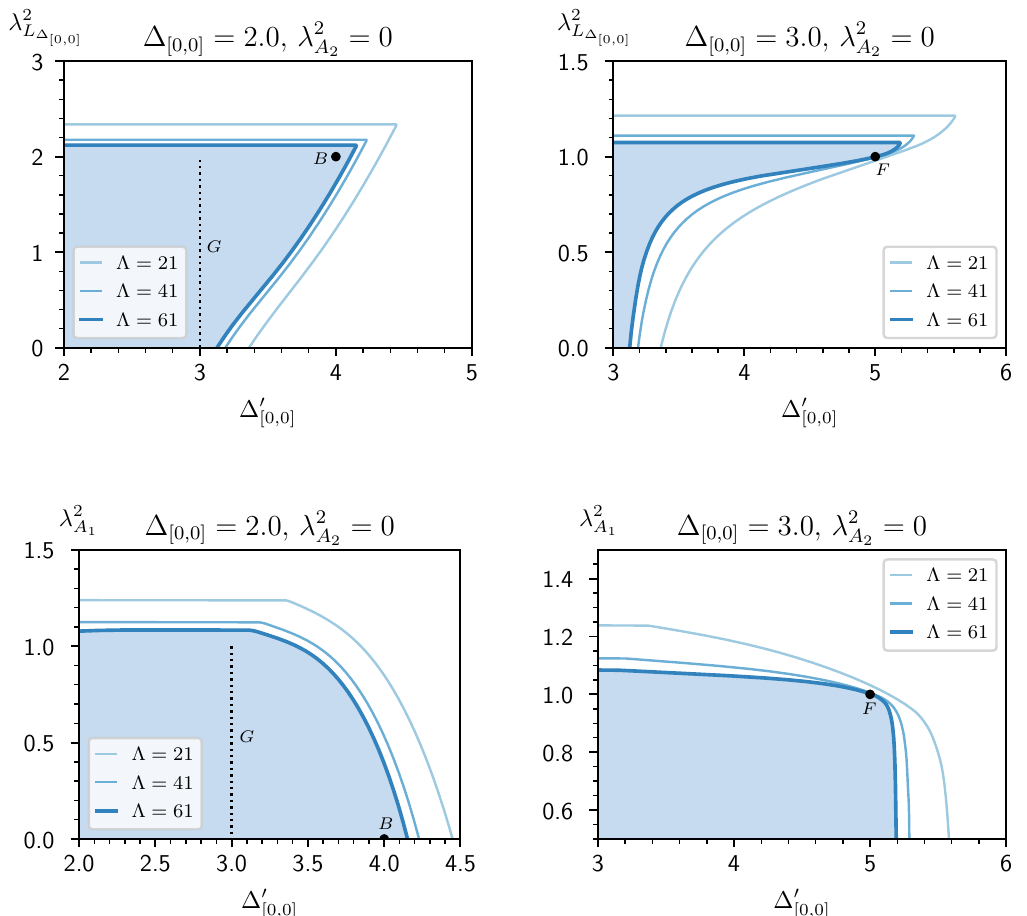
Figure 4 . Upper and lower bounds for (cid:21) 2 (cid:1) 0 when (cid:21) 2 = 0. In the (cid:12)rst column, (cid:1) A 2 [0 ; 0] theory sits at the boundary of the allowed region. In the second column, (cid:1)